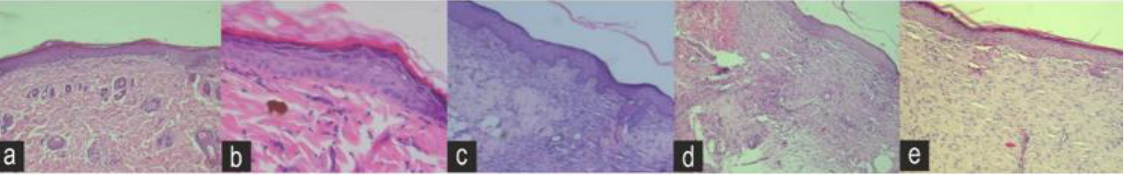
Figure 7. Histopathology sections of the ( a ) negative control (NEG) ( b ) positive control (POS) ( c ) Naringin (NAR) ( d ) Eicosane (EIC) and ( e ) Octacosane (OCT) groups on day 12 under an x20 mag- nification.